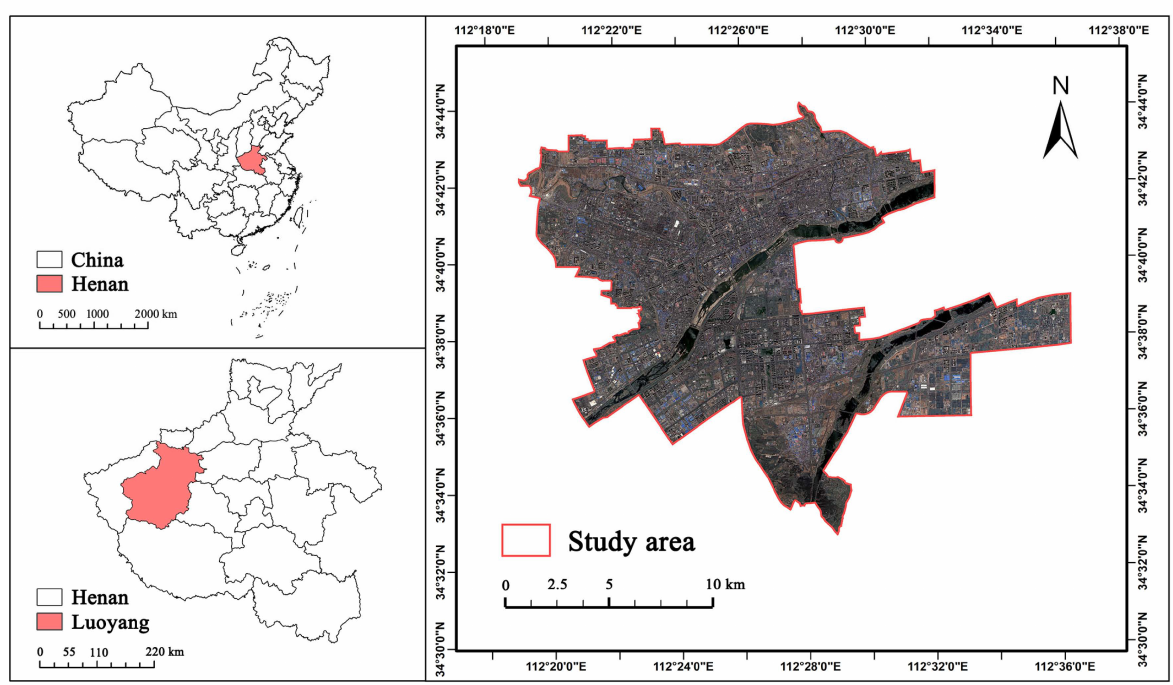
Figure 1. Location of Luoyang city, Henan,